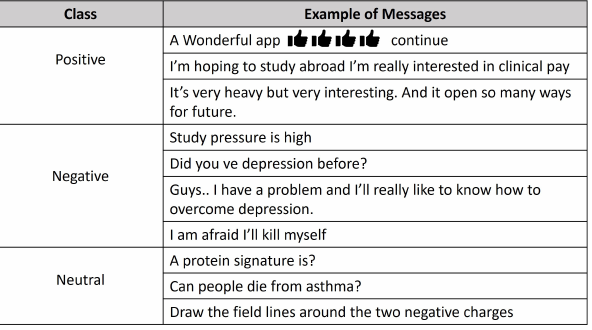
Figure 2. Examples of messages.